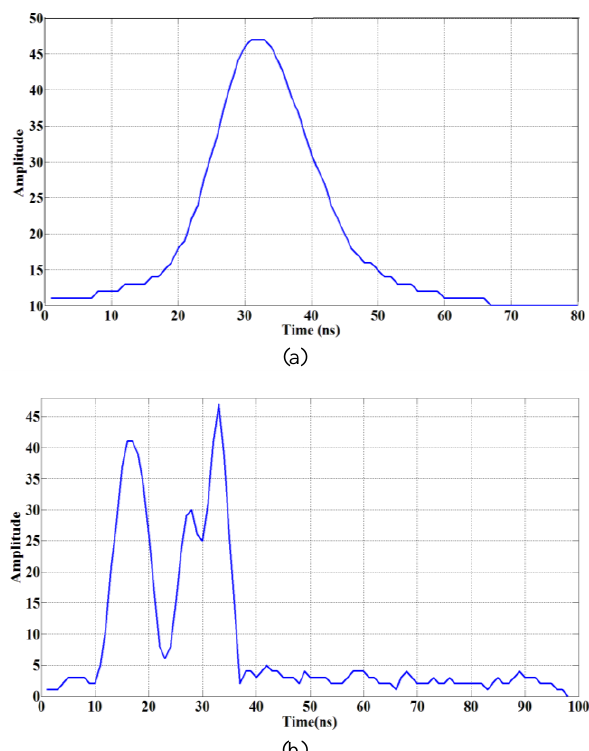
Figure 3. Samples of received waveforms over different terrain, from the Optech ALTM 3100 (a) and Riegl LMS-Q560 (b)